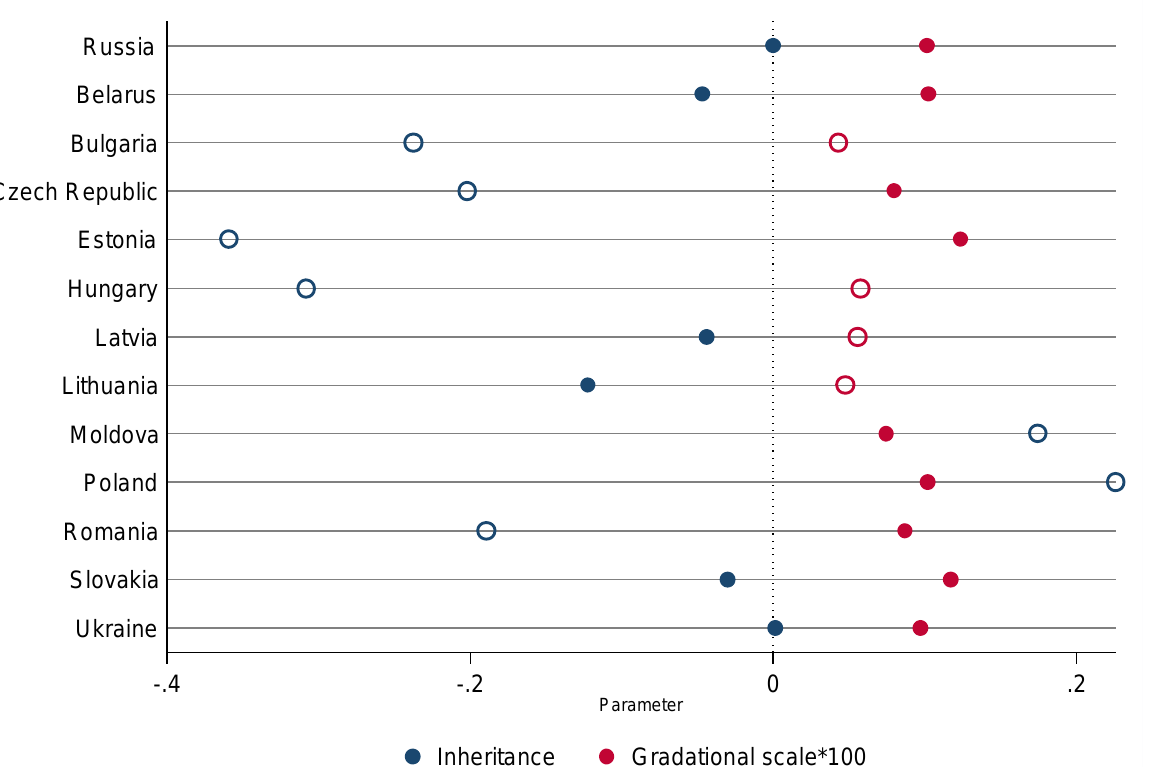
-.4 -.2 0 .2 Parameter